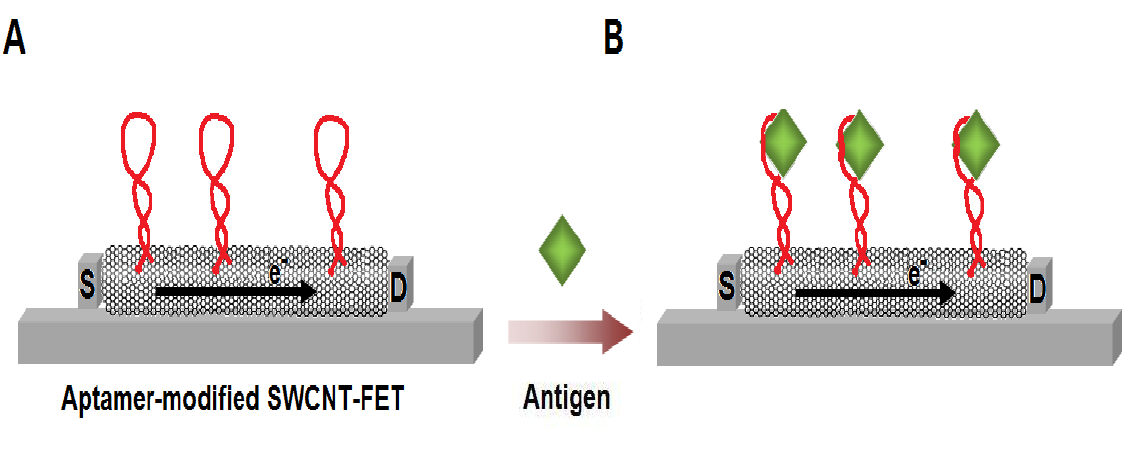
Figure 7. Schematic illustration of the SWCNT-based field-effect transistor (SWCNT-FET) for the label-free aptamer-based sensing. (A) As the aptamers are attached on the SWCNT, the electrical flow from the source (S) to the drain (D) of the system changes. (B) The current flow is further altered upon the binding of the antigens to the